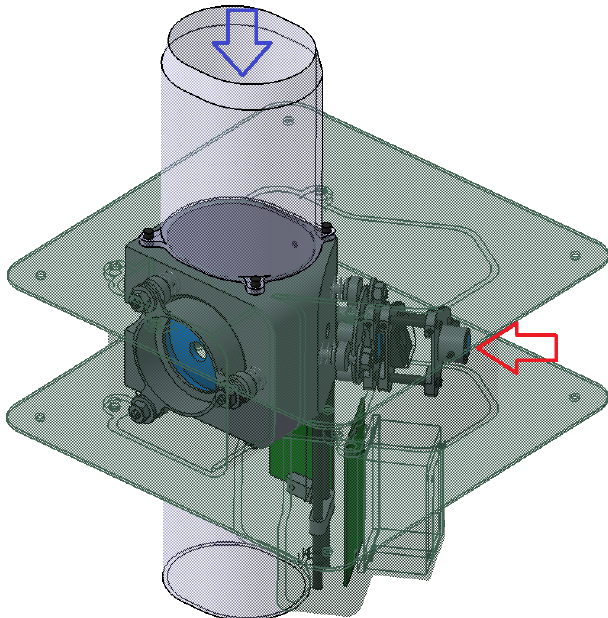
Figure 2. The RCASS – a mechanical redesign of the UCASS (Smith et al., 2019). The red and blue arrows are the laser beam and airflow directions,